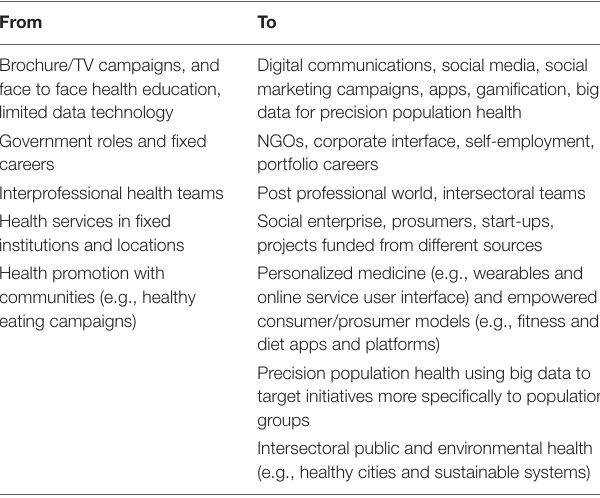
TABLE 1 | Digital age employment: the implications for public health jobs in the 21st century. From